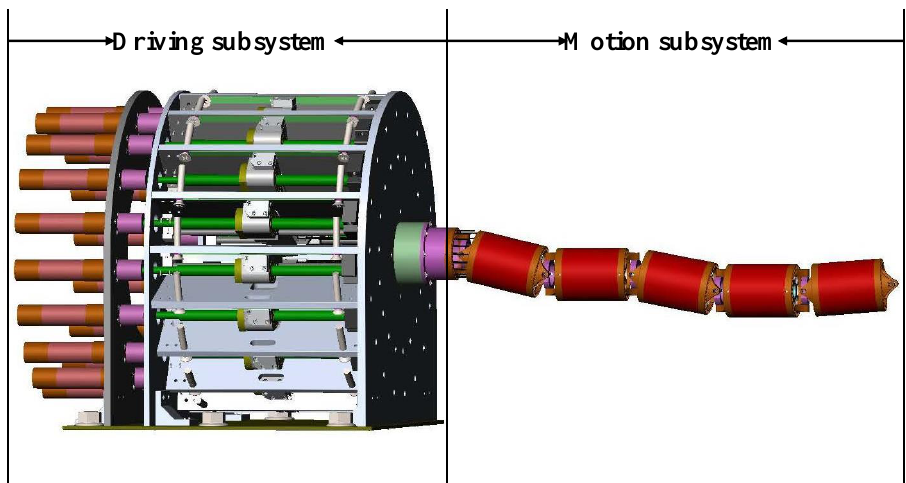
Figure 1. The general structure of CHCM, consisting of the driving subsystem and the motion subsystem.